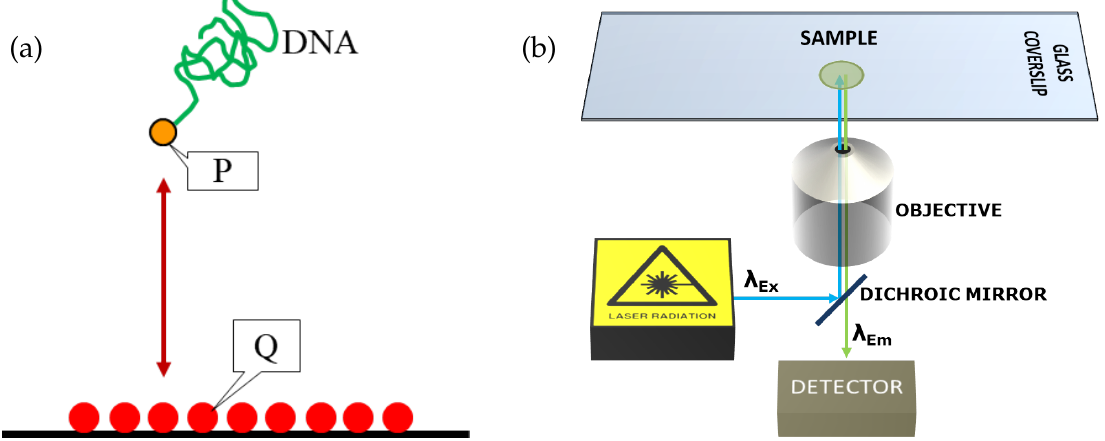
Figure 3. ( a ) Tethering strategy for DNA molecules. P and Q are a pair of binding entities. For example, P could be biotin, a thiol group or digoxygenin. Q could be streptavidin, gold or anti-digoxygenin-IgG, respectively. ( b ) Schematic diagram of a typical fluorescence microscopy